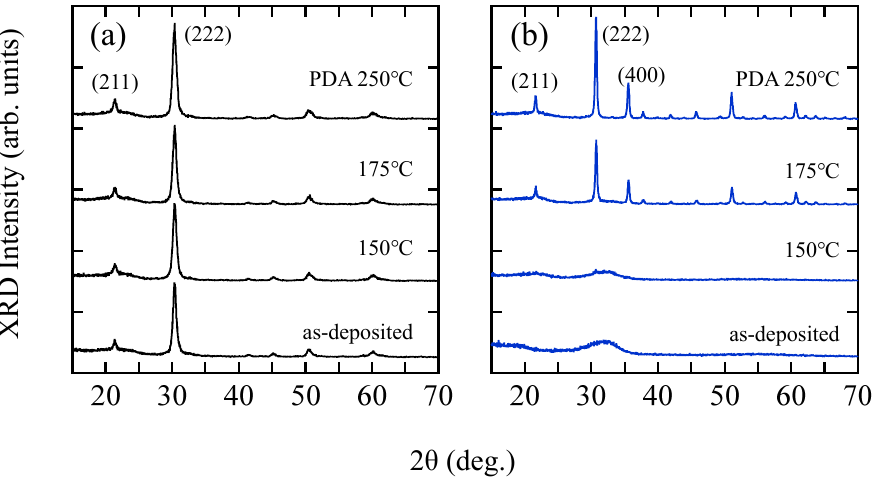
Figure 2. Changes in XRD spectra of ( a ) InO x and ( b ) InO x :H [R(H 2 ) = 5%] films with PDA at different temperatures.